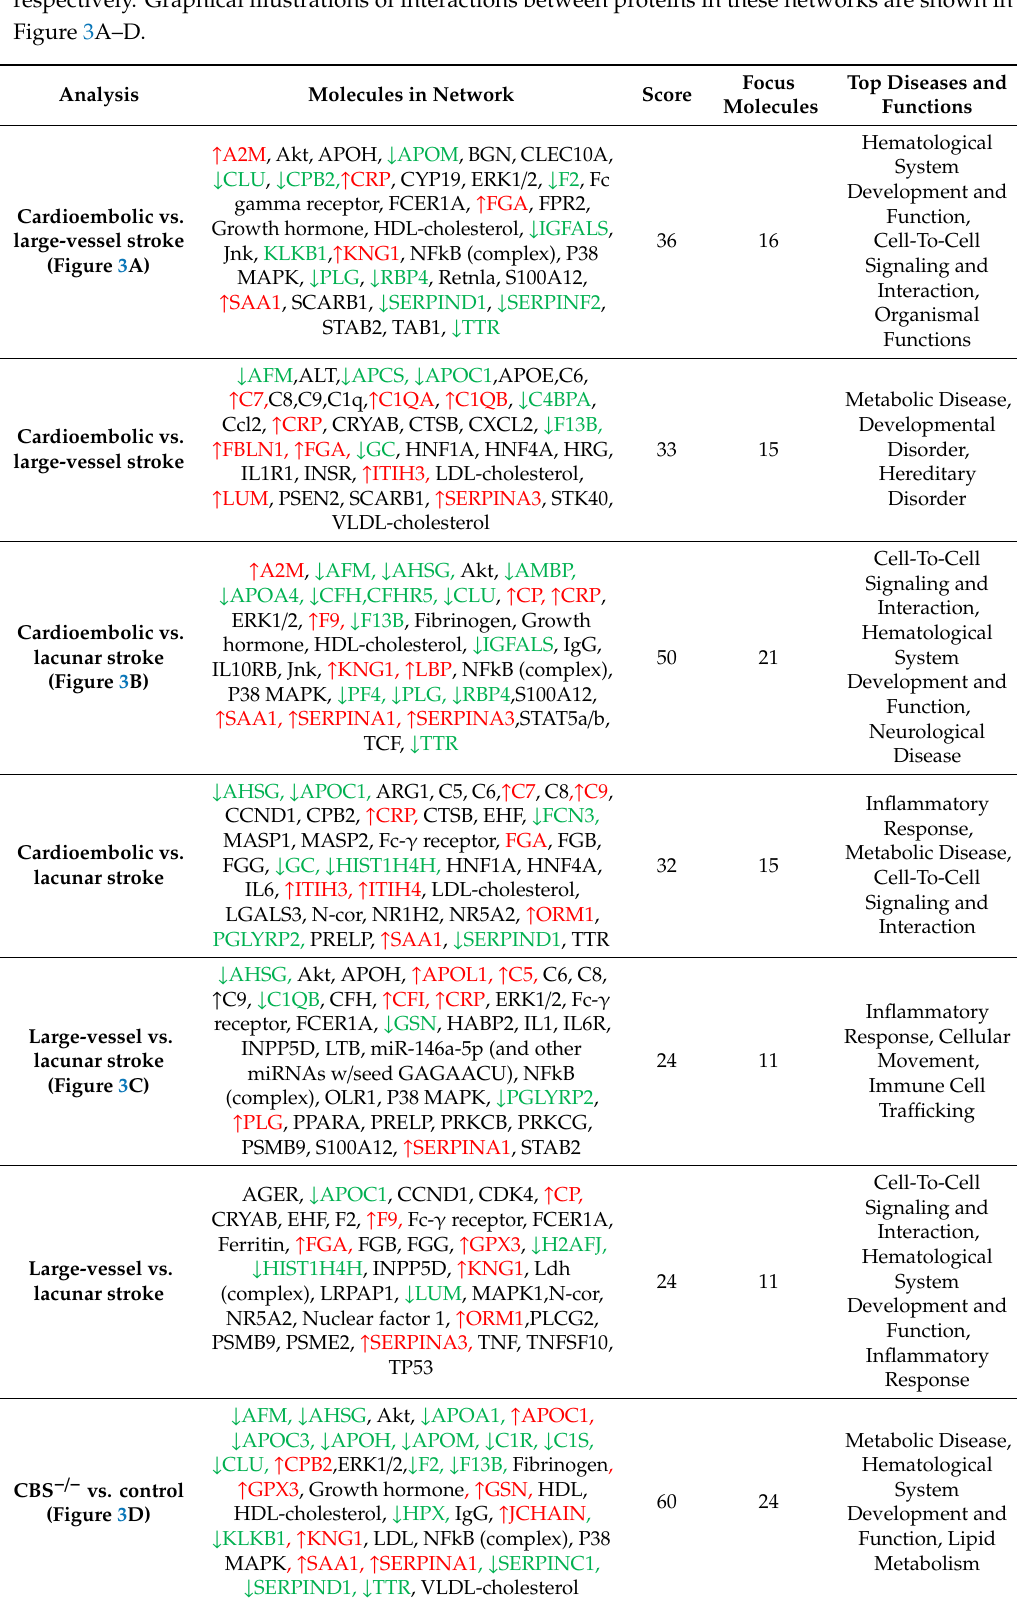
Table 5. Top molecular networks of stroke subtype-responsive and CBS deficiency-responsive proteins in the human serum. Upregulated ( ↑ ) and downregulated ( ↓ ) proteins are highlighed in red and green, respectively. Graphical illustrations of interactions between proteins in these networks are shown in Figure